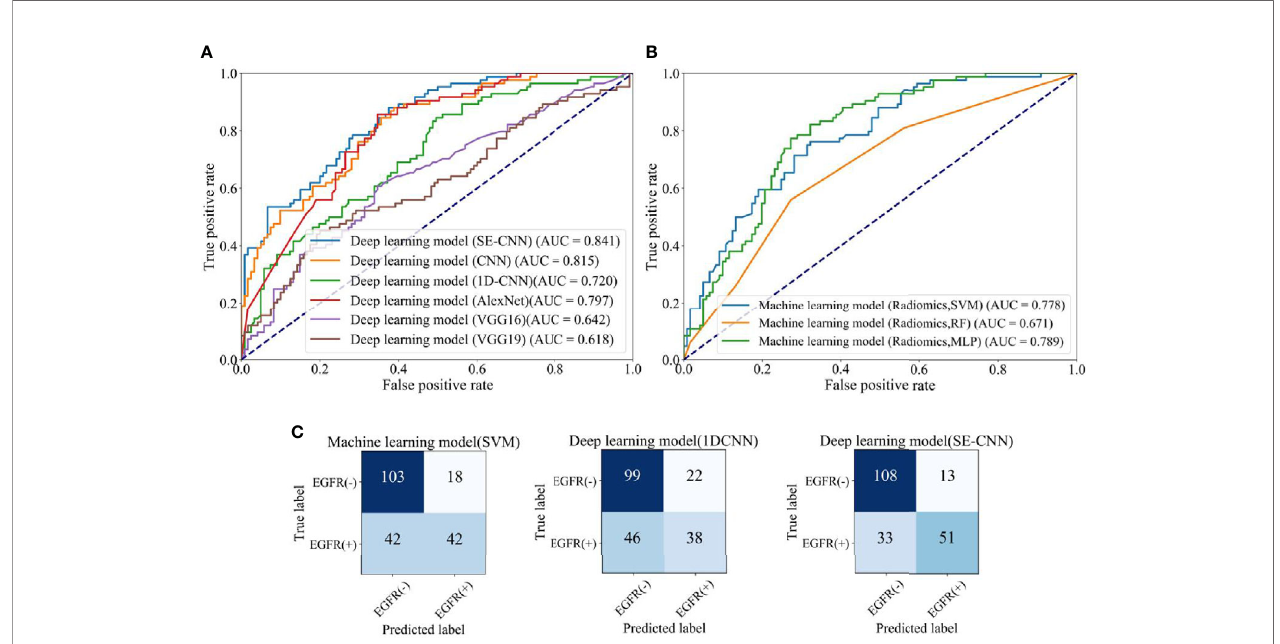
TABLE 4 | Performance comparison between our EGFR predictive model and the state-of-art. Experiments